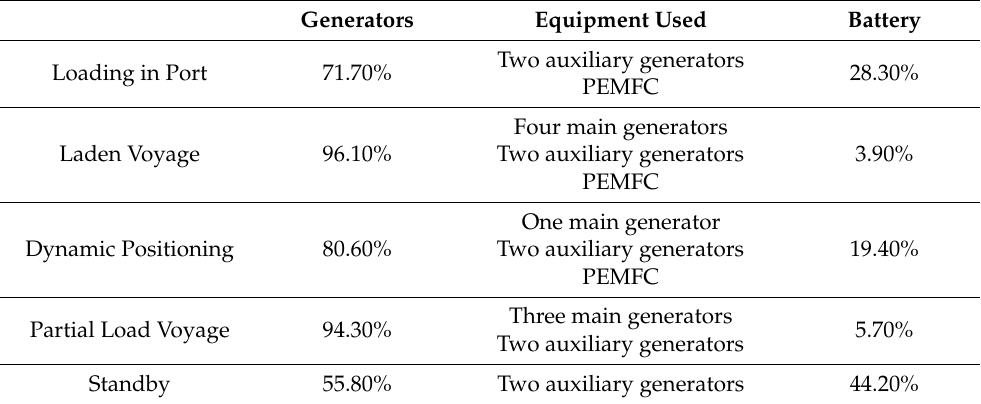
Table 7. Energy contributions in percentages of the generators and the battery that compose the configurations that achieved the highest emission reductions for the normal